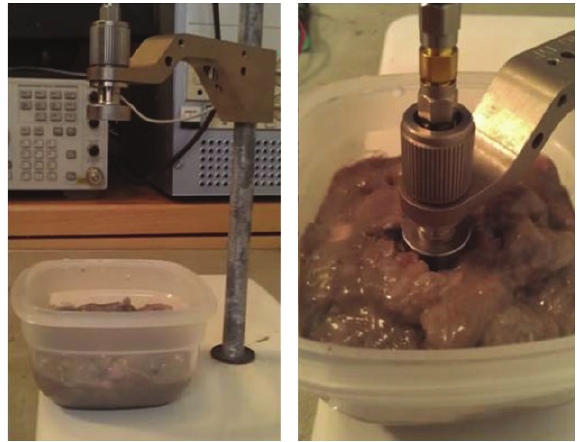
Figure 2: Minced pig’s eye tissue measurement